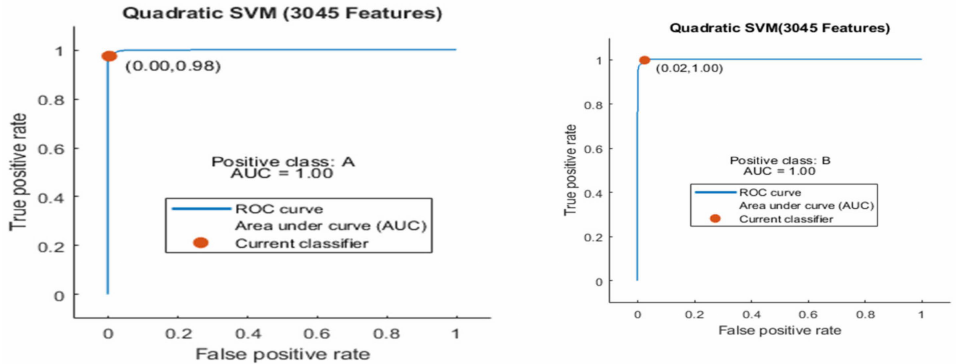
Figure 9. ROC curve for two classes A and B with 3045 features and using 5-fold